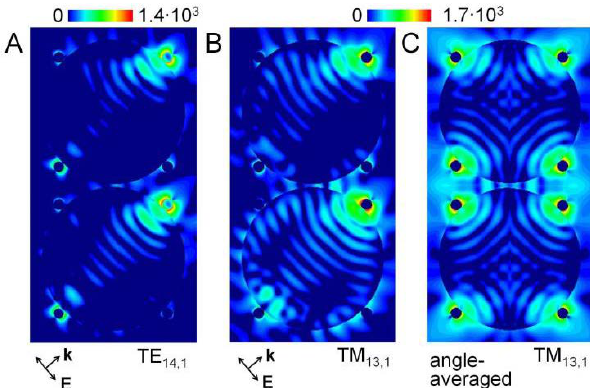
Figure 1: E -field intensity distributions in the discrete opto- plasmonic dimer at the wavelength of the hybrid TE 14,1 (A, λ = 580.9 nm) and TM 13,1 (B, λ = 590 nm) mode. The dimer is composed of two 2 µ m polystyrene microspheres (refractive index = 1.59), each encircled by four 148 nm diameter Au nanoparticles separated from the microsphere surface by 1 nm gaps. The insets show the direction and polarization of the incident plane wave. (C) Near-field intensity distribution at the TM 13,1 mode wavelength averaged over the in-plane angle of incidence. Reprinted with per- mission from Ahn et al. ACS Nano 6, 951 (2012). Copyright 2012 American Chemical